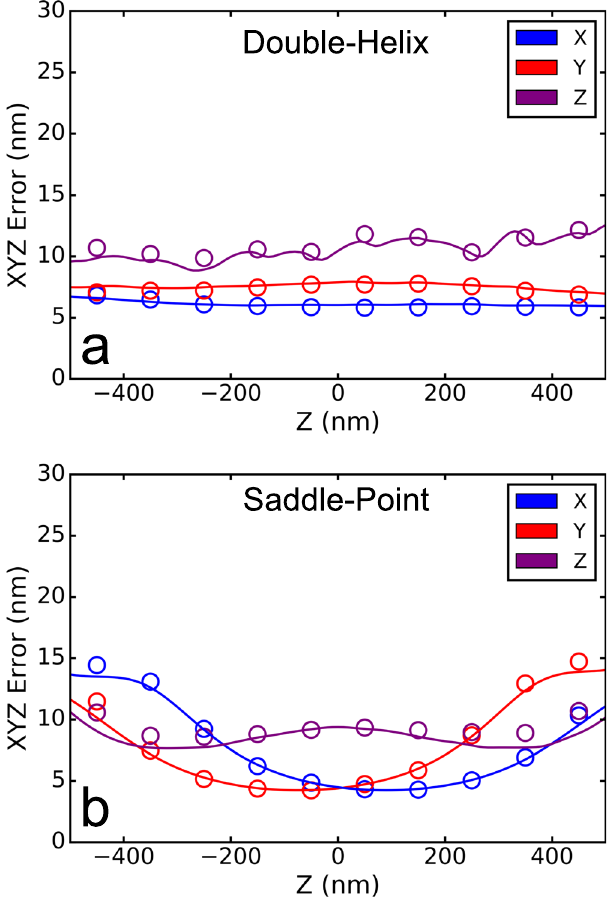
Figure 5. PSF localization accuracy. Localization errors in x, y and z are plotted as a function of z. ( a ) Double helix PSF. ( b ) Saddle-point PSF. The solid lines are the Cramer-Rao theoretical bounds calculated following ref.